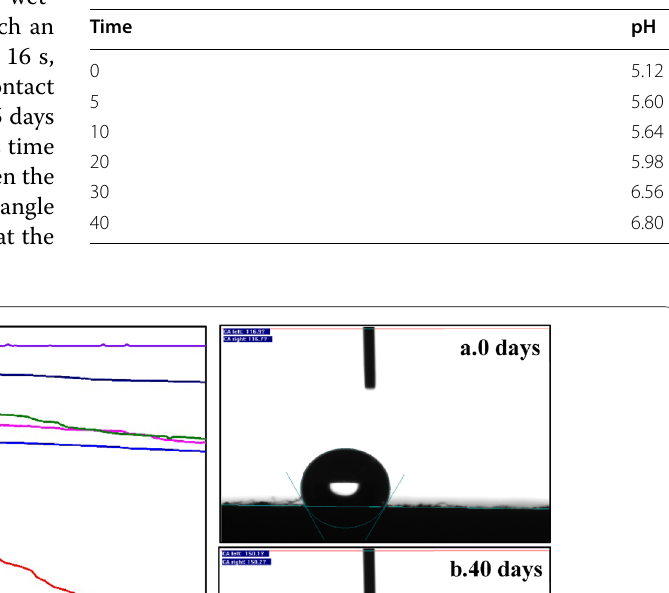
Table 3 Fungi pigment on pH value of rubberwood from